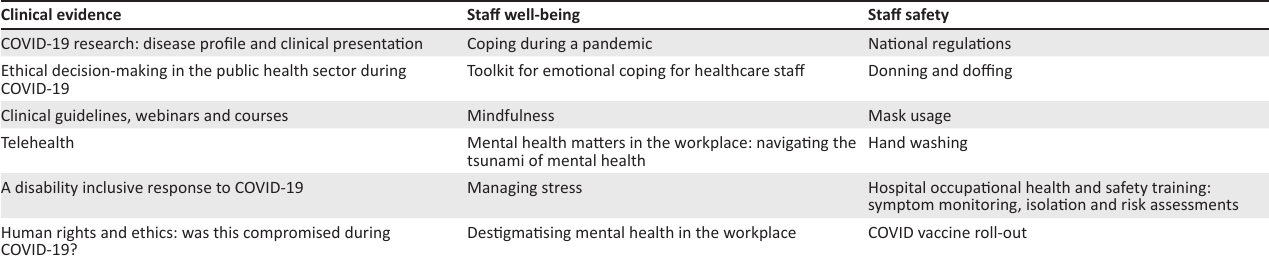
TABLE 3: Speech Therapy and Audiology training and development